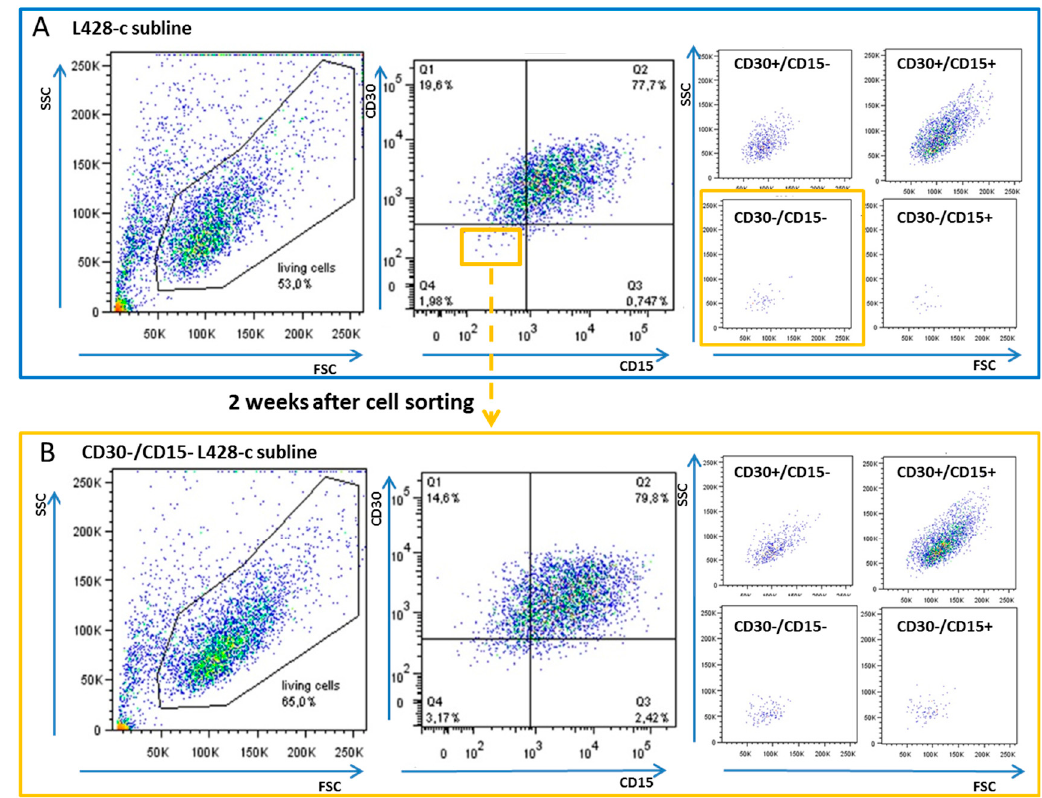
Figure 1. CD30 − /CD15 − cells from the L428-c subline acquire a phenotype similar to that of the parental cell lines. The proportion of cell-surface forward-scattered (FSC) vs. side-scattered (SSC) signal is presented for the L428-c subline and each subpopulation according to CD30 and CD15 staining. ( A ) L428-c subline cells were stained for CD15 and CD30 and CD30 − /CD15 − cells (yellow insert) were sorted by fluorescence-activated cell sorting. ( B ) CD30 − /CD15 − cells from the L428-c subline after two weeks of in vitro culture, showing a similar profile to that of the L428-c subline. There was a higher proportion of CD30 − /CD15 − cells in the negative sorted cells after two weeks of in vitro culture than in the L428-c subline (3.17% vs. 1.98%). The CD30 − /CD15 − cells in the L428-c subline, as well as those in the sorted cell population sorting after in vitro culture, were small. Three independent cell-sorting experiments were performed.